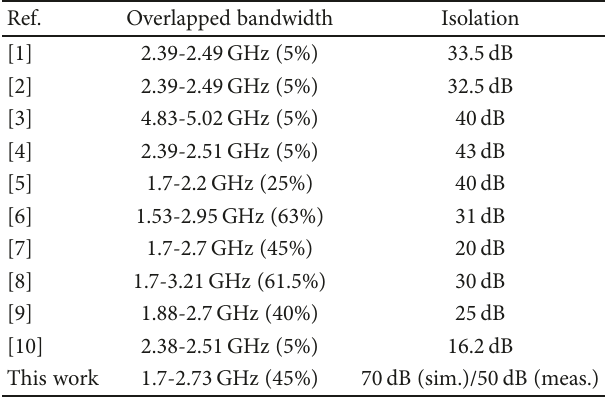
Table 2: Comparison of this work with reported DP antennas.